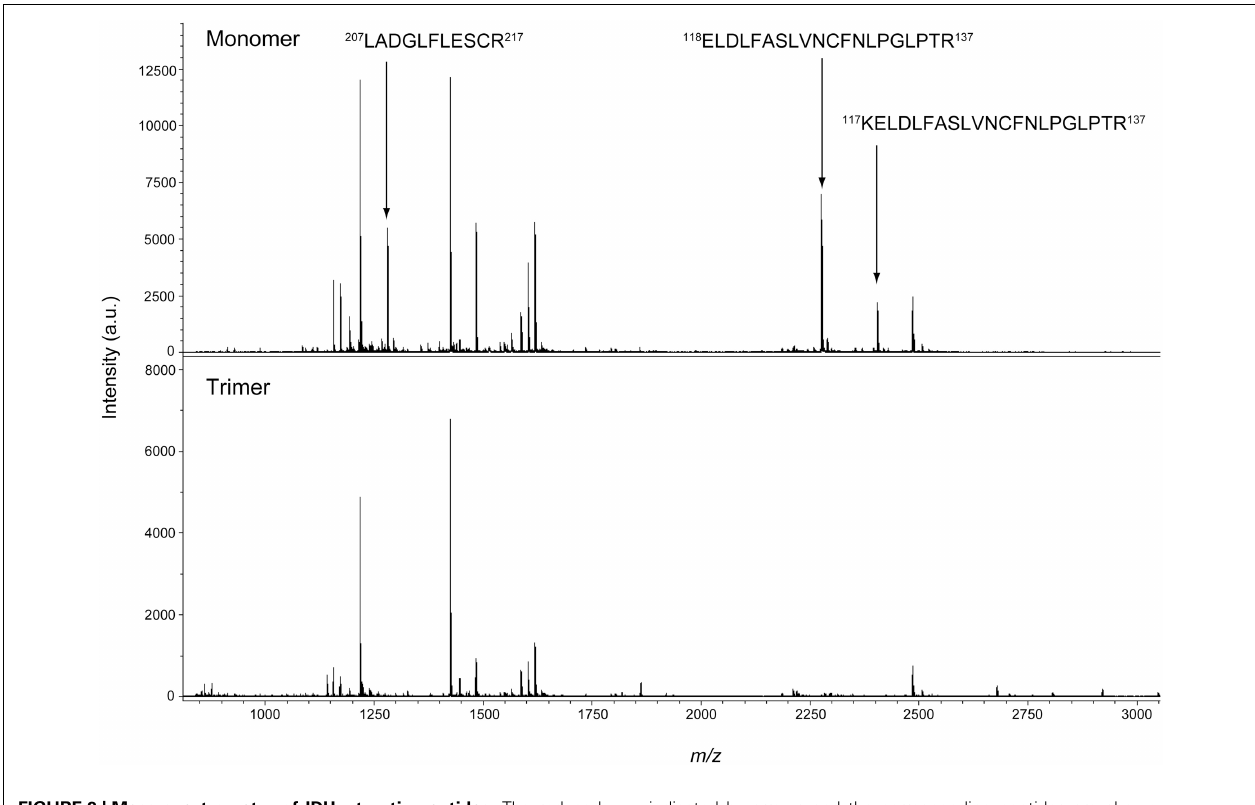
FIGURE 3 | Mass spectrometry of IDH-r tryptic peptides. The reduced monomeric form (Upper panel) and the oxidized trimeric form (Lower panel) were analyzed. The specific signals for monomeric form are